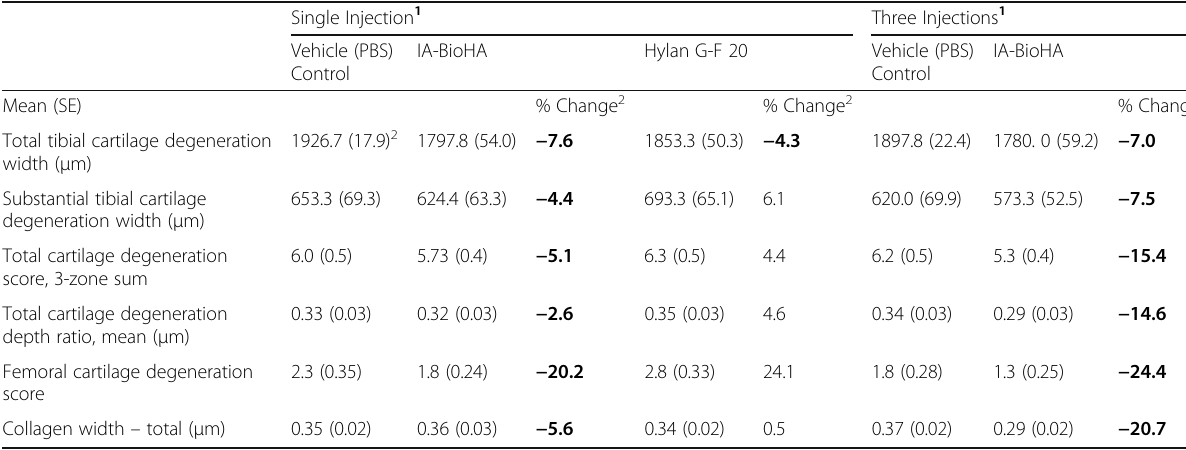
Table 1 Summary of Knee Morphometry